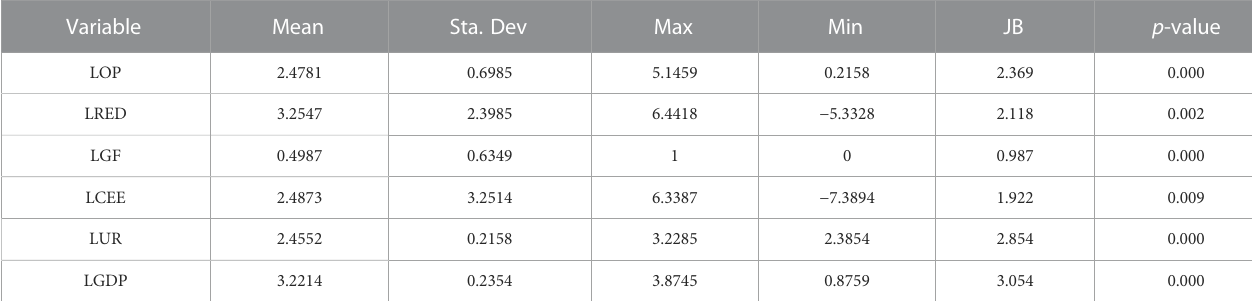
TABLE 2 Summary statistics.